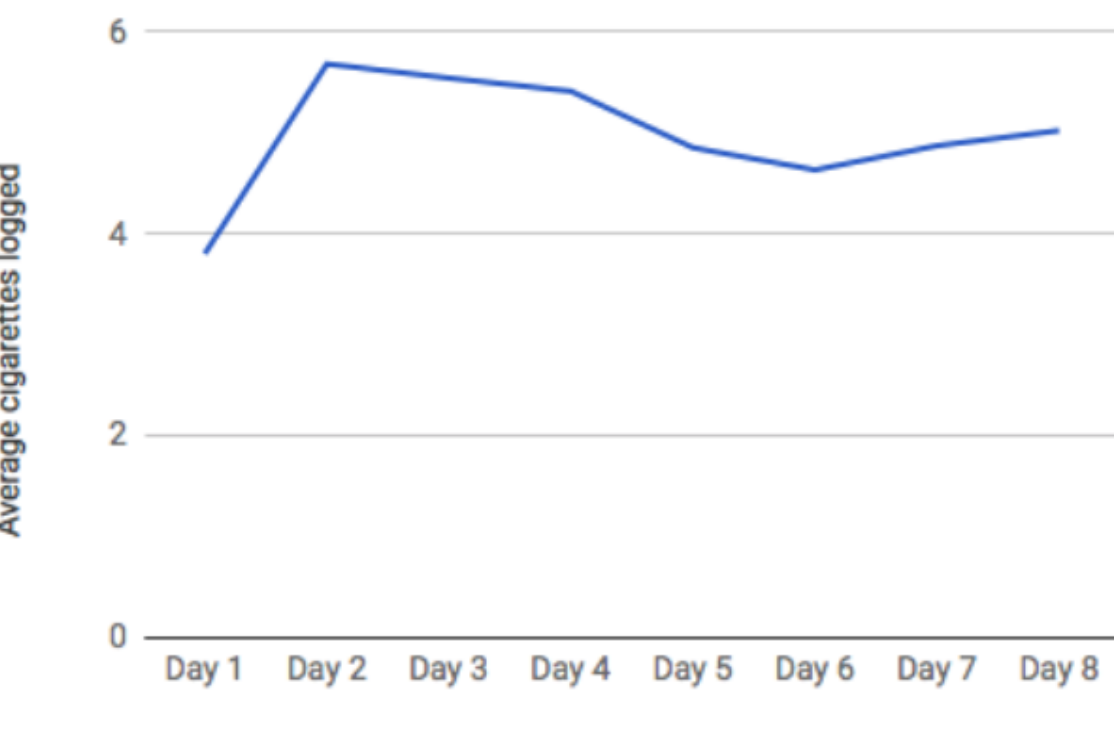
Figure 6. Average cigarettes logged in-app per person per